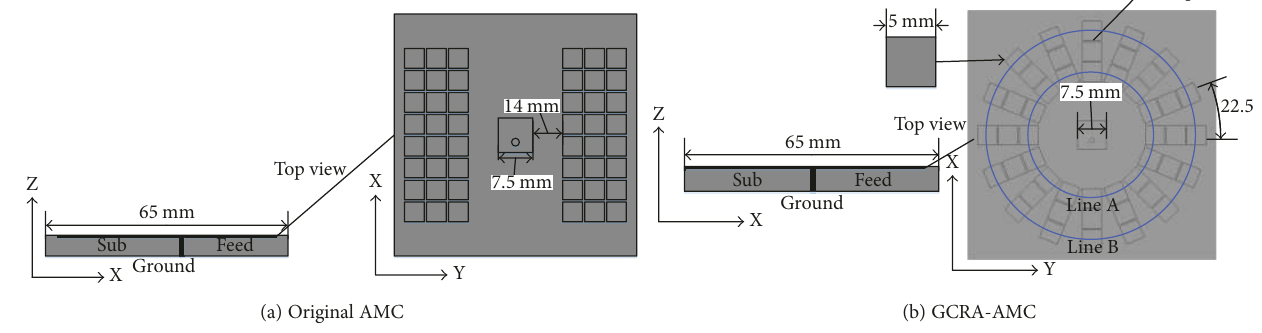
Figure 1: The con fi guration of the antenna with AMC.